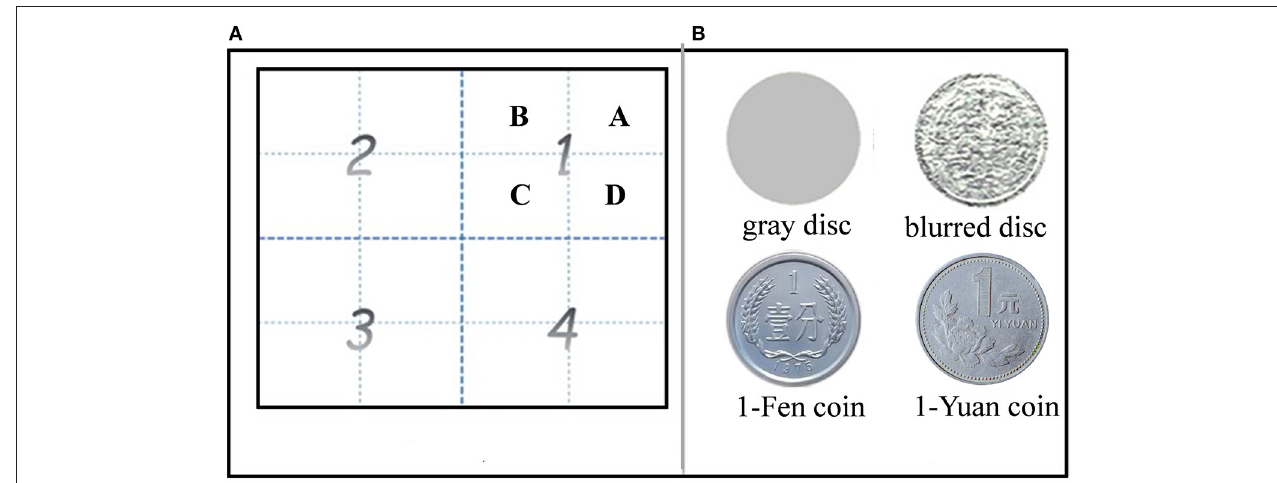
FIGURE 1 | Partition of the screen for stimulus presentation (A) and stimuli used in the experiment (B) . (A) Four quadrants (marked by numbers) were divided into a total of 16 equal-size grids (four per quadrant, labeled by letters). (B) Stimuli were gray disk (top left), blurred disk (top right), 1-Fen (bottom left), and 1-Yuan (bottom right) Chinese coins.